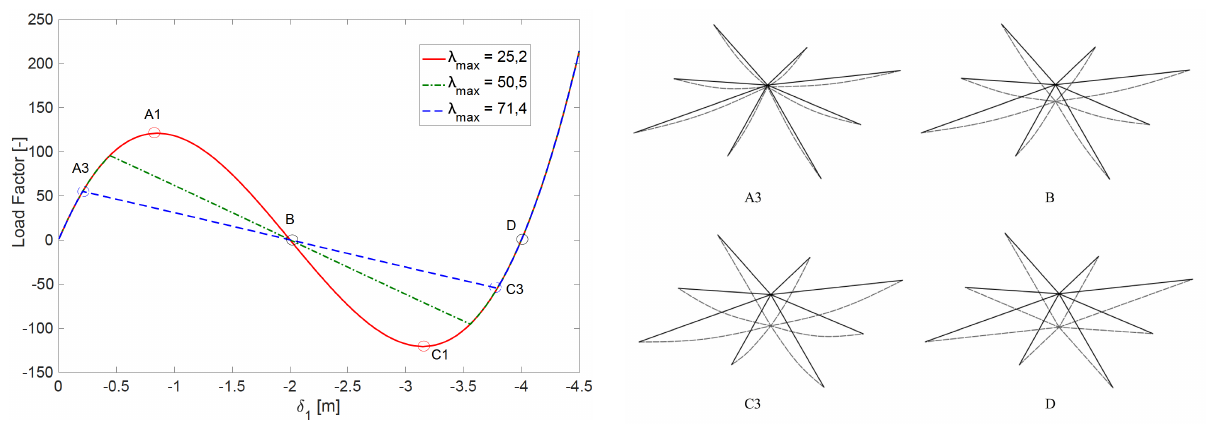
In Figures 5 and 6, some deformed configurations are